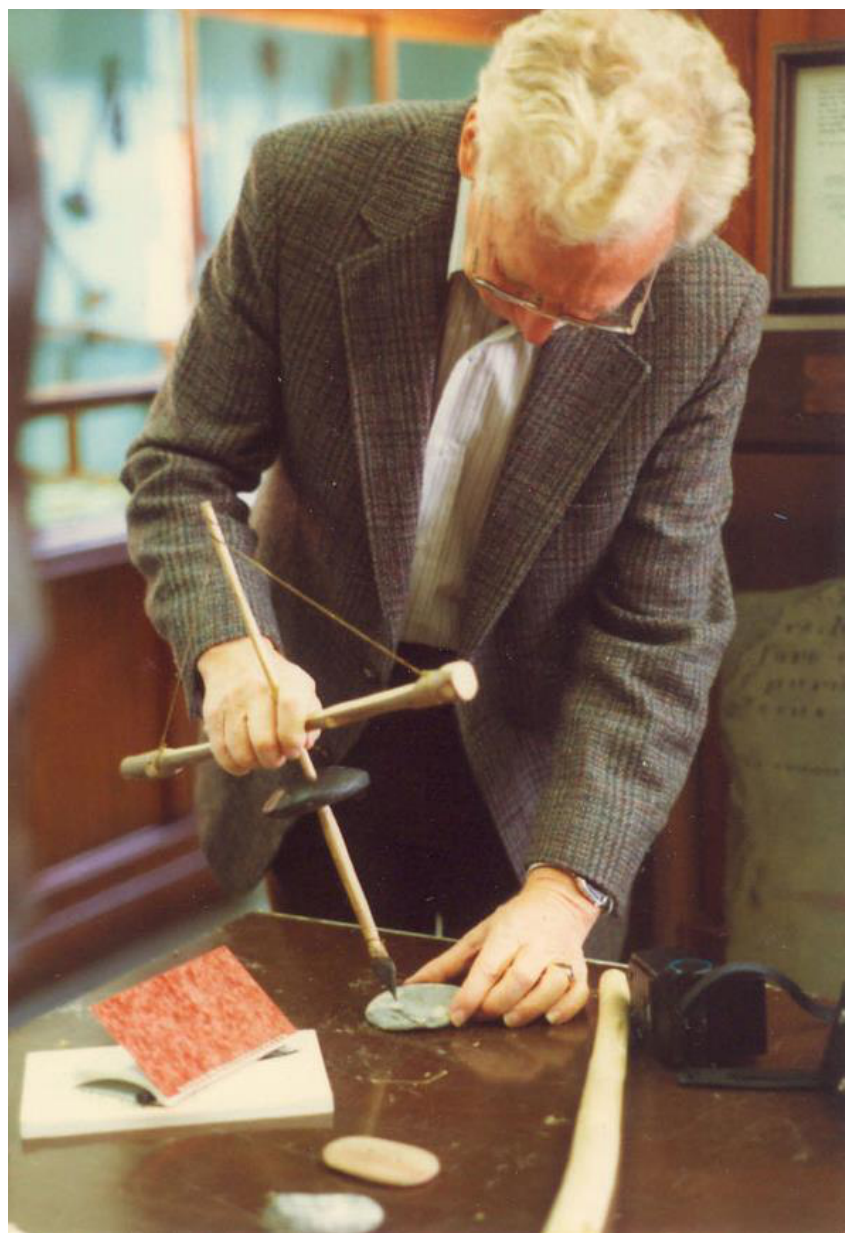
Figure 3. Jack Holland demonstrating a stone drill. (Photo by Jack